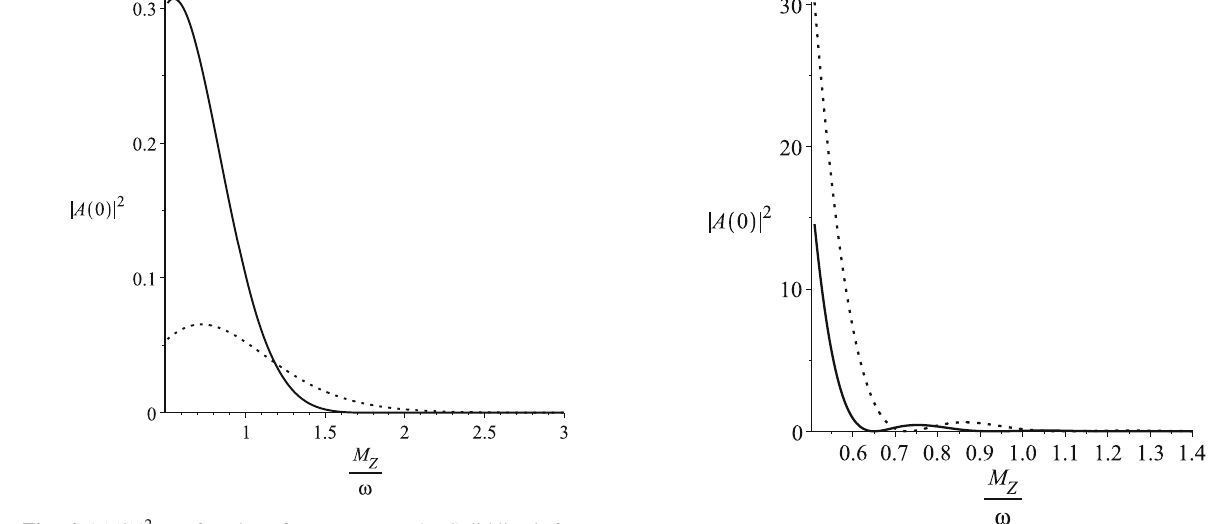
Fig. 6 | A ( 0 ) | 2 as a function of parameter M Z /ω . Solid line is for p = 0 . 5 , p (cid:11) = 0 . 4 , P = 0 . 1, while the point line is for p = 0 . 5 , p (cid:11) = 0 . 3 , P = 0 . 2